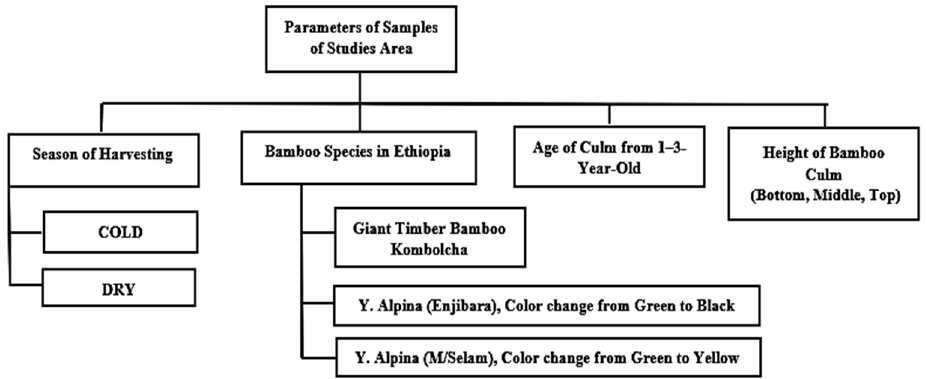
Figure 2. Sample taking techniques of the bamboo culm.